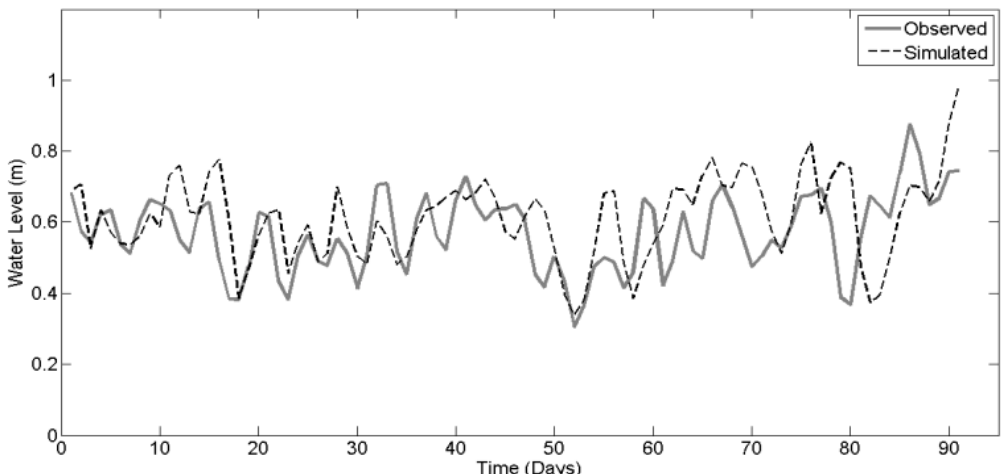
Figure 4. Temporal variability of observed (solid grey line) and calculated (dashed black line) water levels at P3 station from January 1, 2001, to May 31, 2001.